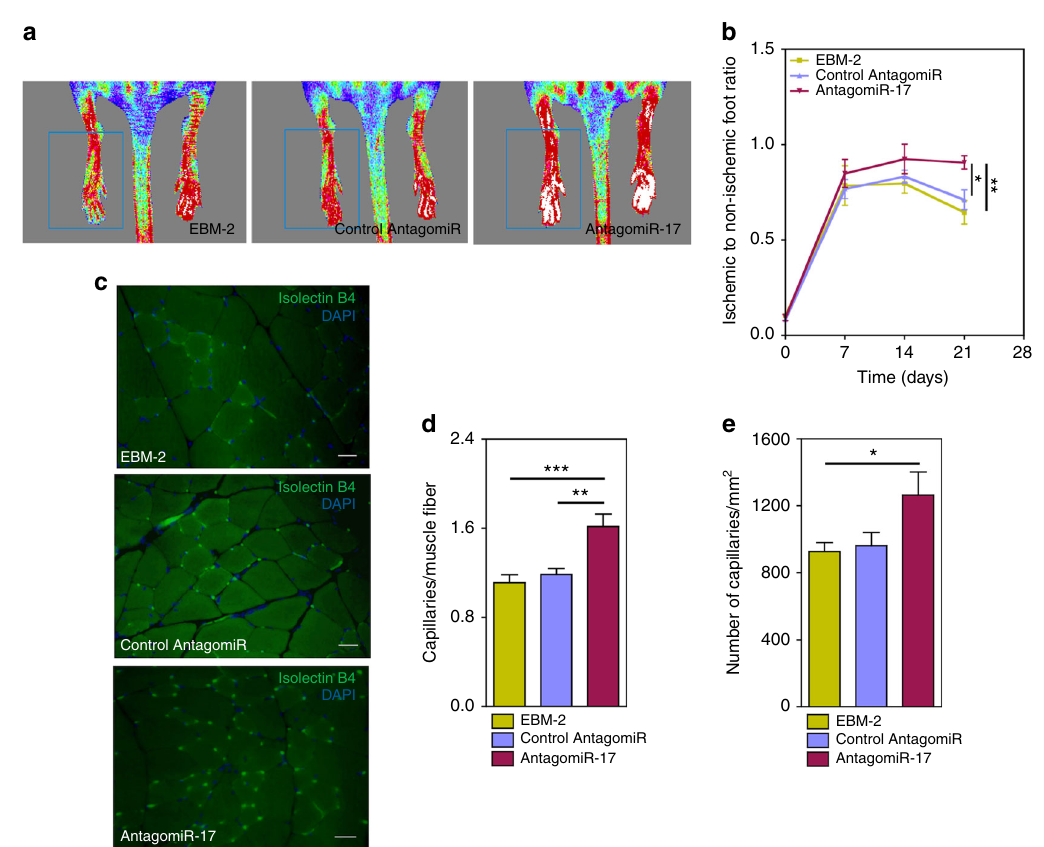
Fig. 5 AntagomiR-17 -treated OEPCs increase blood fl ow recovery and capillary density in a mouse model of hindlimb ischemia. a , b Unilateral limb ischemia was induced in female CD1 nude mice by occlusion of the left femoral artery. Immediately after occlusion, the ischemic muscles were injected with 3 million antagomiR-17 -transfected OEPCs or 3 million control antagomiR-transfected OEPCs. Control group received only EBM-2. Blood fl ow recovery was measured using high-resolution laser color Doppler imaging and calculated ( n = 12 mice/experimental group) as a ratio of ischemic over contralateral foot blood fl ow. c – e 21 days after surgery, limb muscles were harvested and prepared for immunohistochemical analyses. Capillary density in the adductor muscle was measured by staining with isolectin B4 (revealing endothelial cells) ( c ). The relative amount of positive cells was counted in eight randomly selected high-power fi elds (magni fi cation ×20). Scale bars , 20 μ m. ( d , e ). Data were shown as mean ± SEM. One-way ANOVA followed by a Bonferroni post test was used for statistical analysis. * P ≤ 0.05,** P ≤ 0.01, and *** P ≤